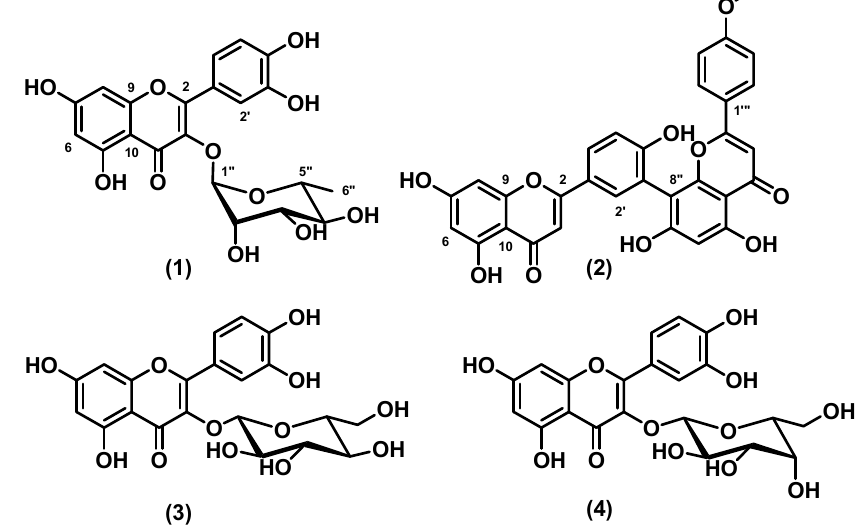
Figure 1. Structures of quercitrin ( 1 ), podocarpusflavone A ( 2 ), quercetin-3- O -  -glucoside ( 3 ), and quercetin-3- O -  -galactoside ( 4